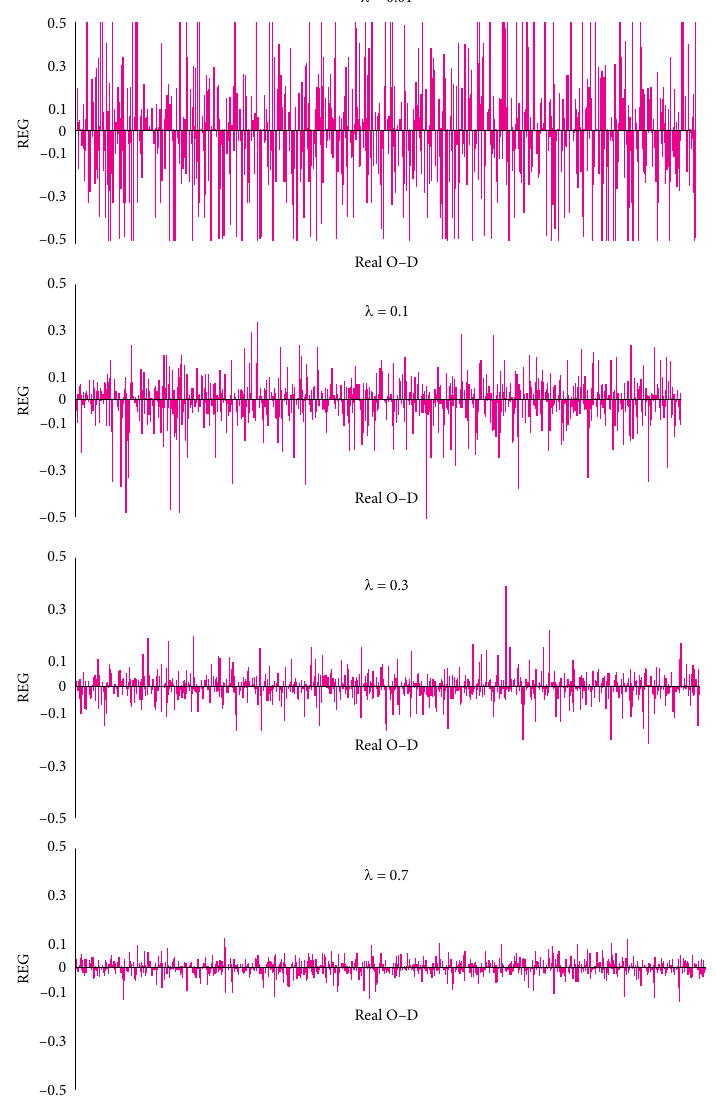
Figure 6. Relative error of the generalized O–D relative versus real demand for different values of l